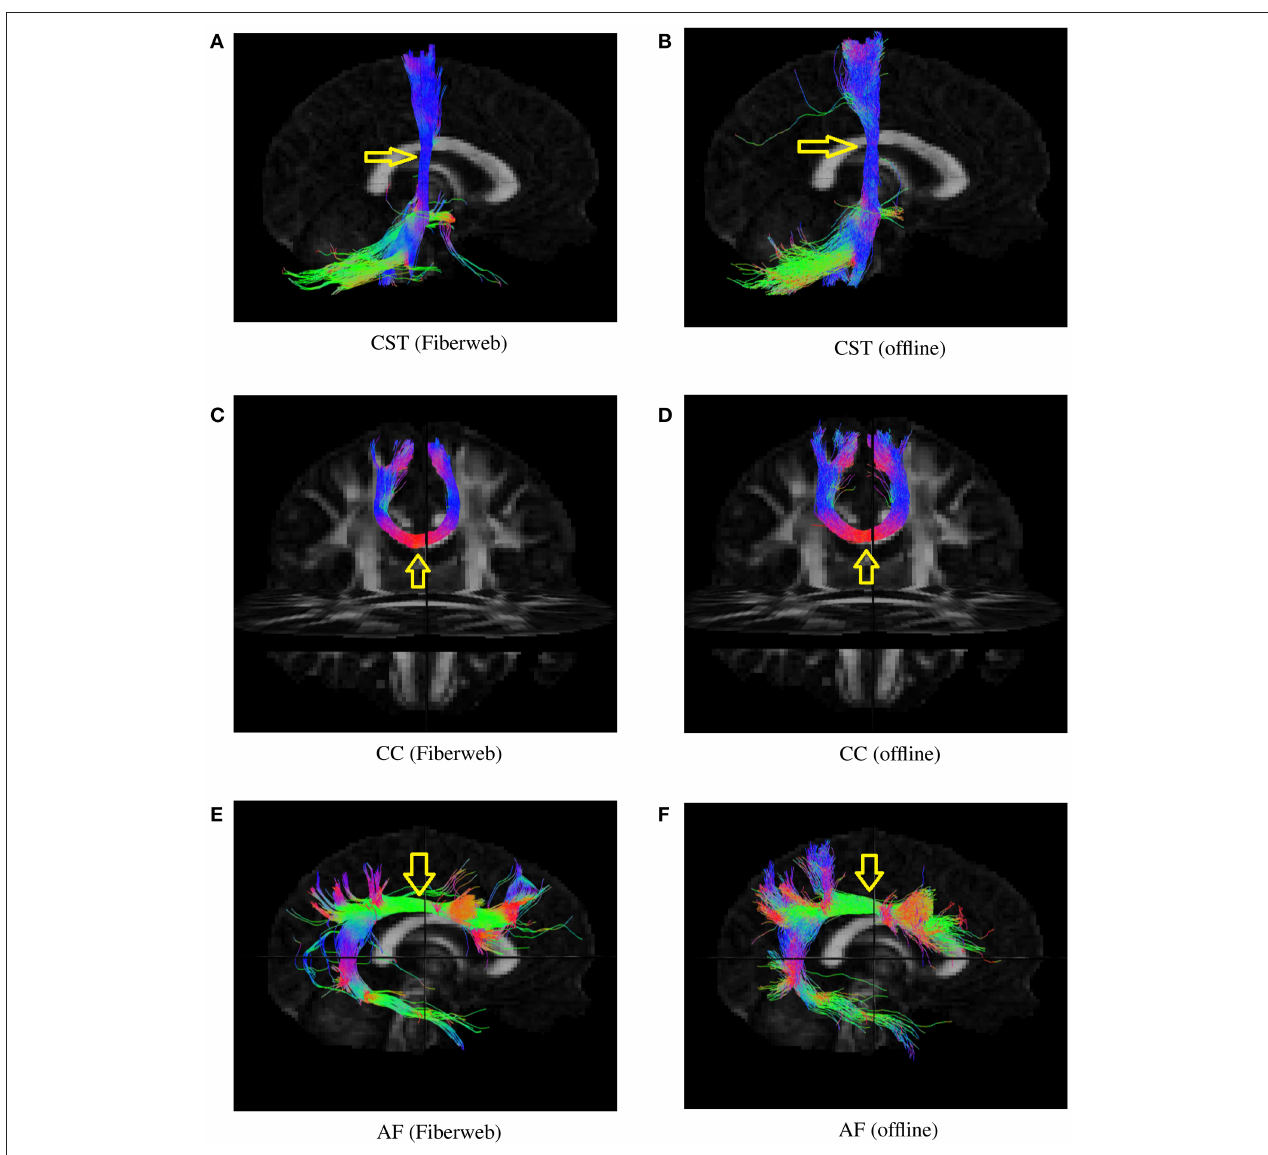
FIGURE 7 | Various bundles resulting from probabilistic tractography (real-time in the Fiberweb vs offline). Dice coefficients are: CST (0.865), CC (0.928), and AF (0.811). The yellow arrows show the location of seeding regions. (A) Results of the Fiberweb algorithm for the corticospinal tract. (B) Results of the offline algorithm for the corticospinal tract. (C) Results of the Fiberweb algorithm for the corpus callosum. (D) Results of the offline algorithm for the corpus callosum. (E) Results of the Fiberweb algorithm for the arcuate fasciculus. (F) Results of the offline algorithm for the arcuate